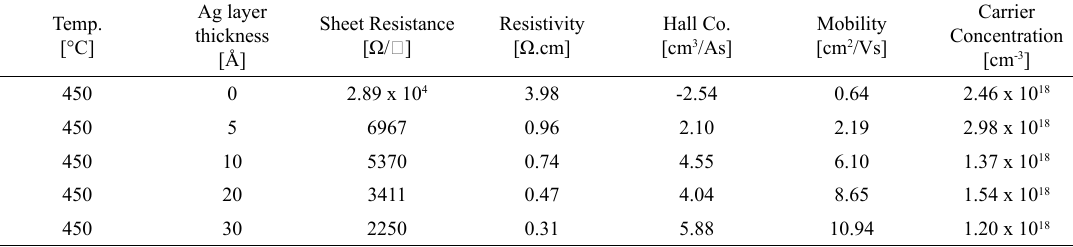
Fig. 7 shows sheet resistance, mobility, and carrier concentration variations by substrate temperature.